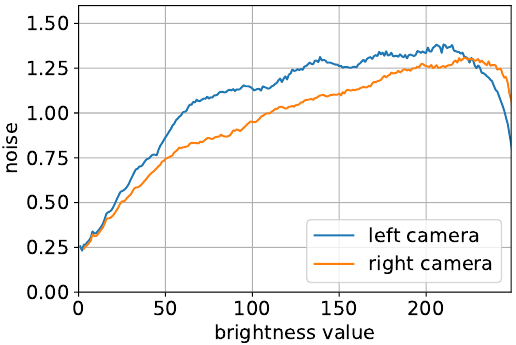
Figure 6. Noise levels of the rectified camera images.